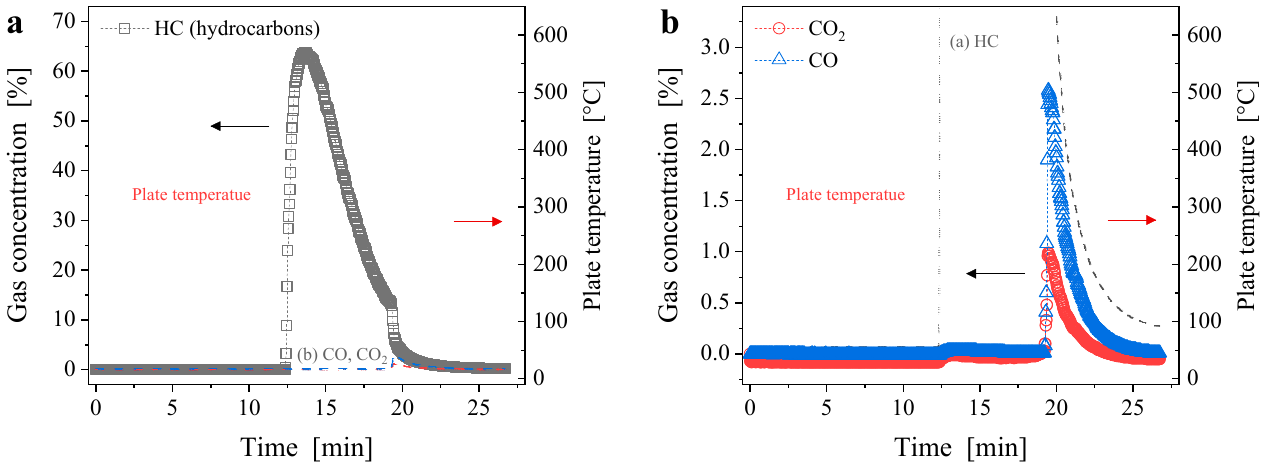
Figure 7. Composition of off-gases of ( a ) volatile organic compounds and ( b ) CO 2 and CO during thermal runaway of lithium-ion batteries. Table 2. Analysis of heavy metal content of electrodes and thermal runaway residues in lithium- ion battery.